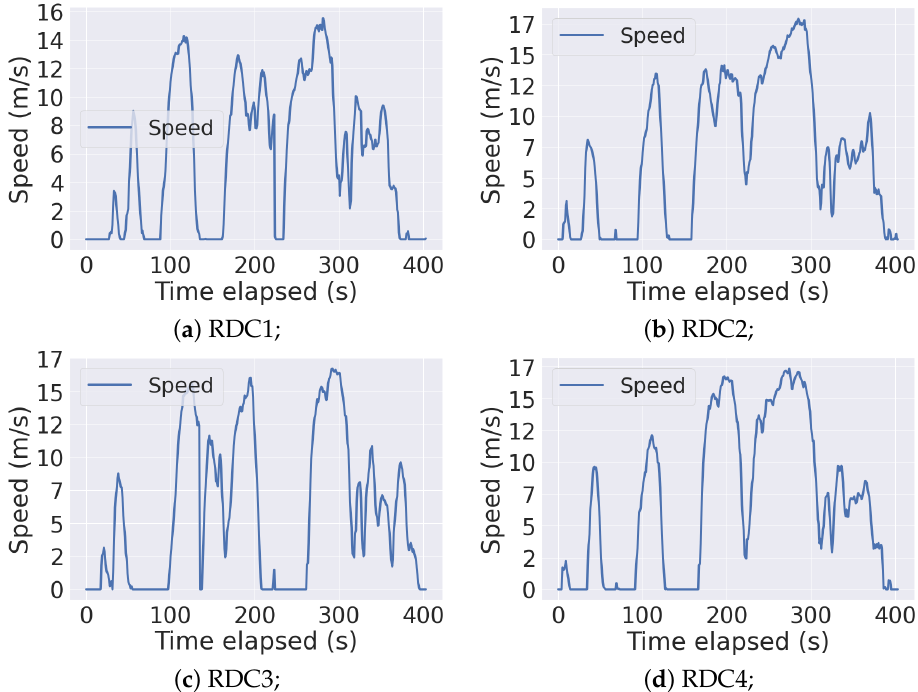
Figure 2. Speed and acceleration over time of the different time series collected by Hong et al.